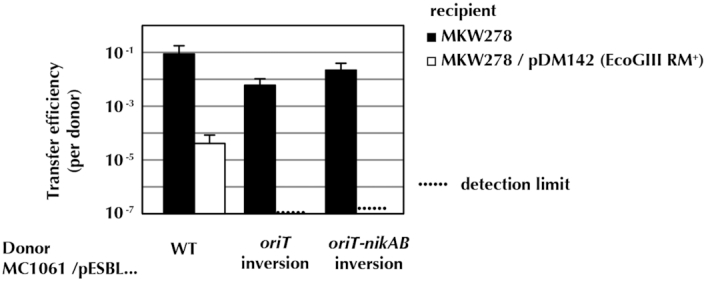
Inversion of pESBL oriT in the donor increases sensitivity to EcoGIII restriction in the recipient. When the recipient lacks EcoGIII (MKW278), transfer per donor is mostly unaffected by inversion of the transfer origin (either ori or a larger segment with both ori and nikAB). When the recipient carries the EcoGIII RM system, the wild type plasmid is restricted ∼104-fold; with the inverted origin, transfer is not detected (106–107-fold restriction). EcoGIII does not cleave when the A in CTGCAG is modified.